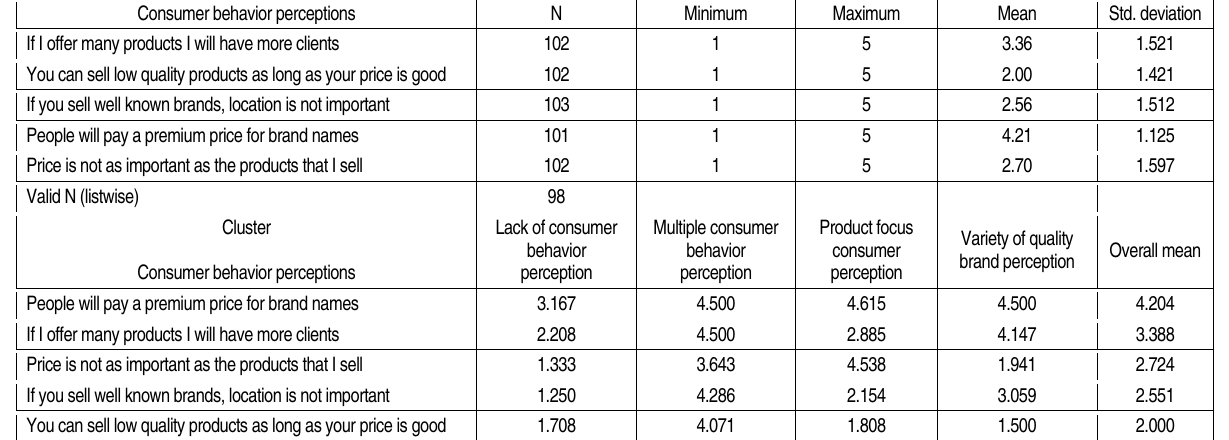
Table 2. Mean level of agreement with consumer behavior perceptions and clusters Consumer behavior